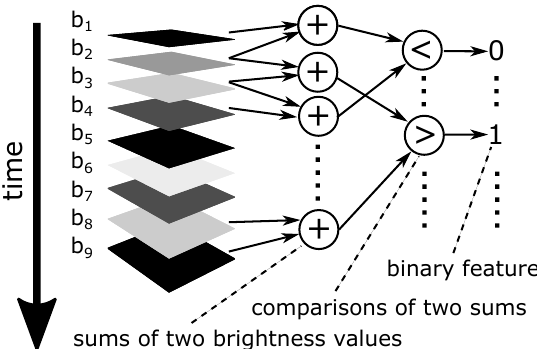
Figure 3. Creation of binary features from two sums of brightness values (BICOS+).